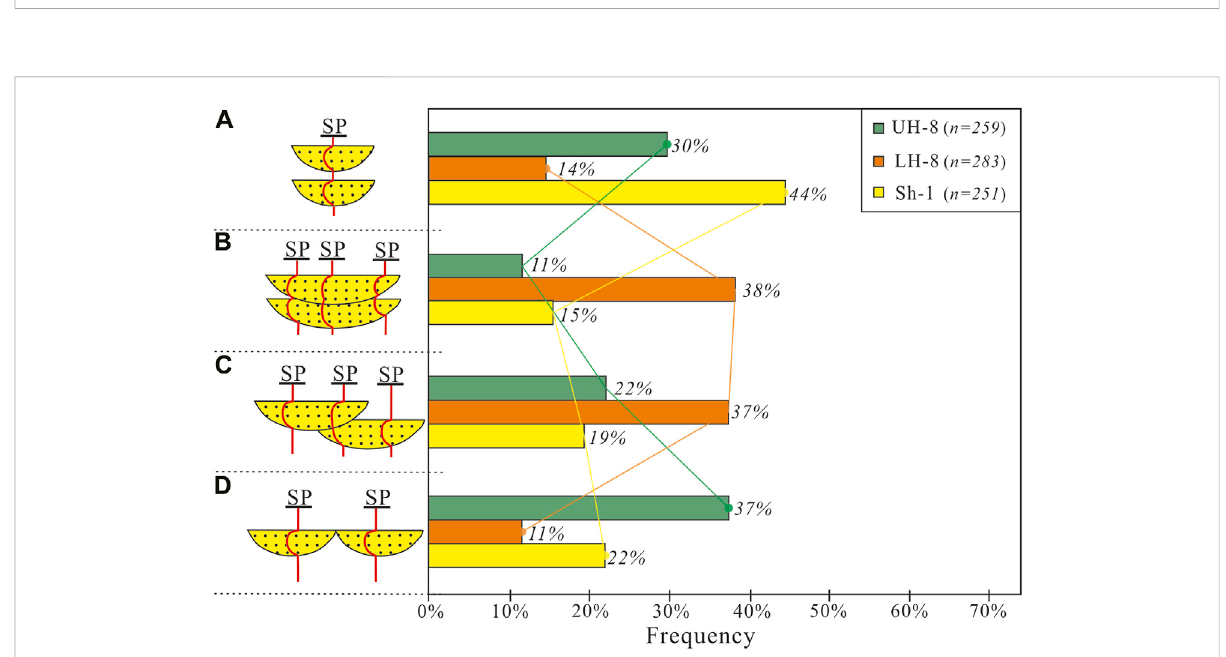
FIGURE 6 Frequency distribution of sand body stacking styles in the Sh-1 and He-8 members. (A) Isolated sand body, (B) vertically superimposed sand bodies, (C) tangentially superimposed sand bodies, and (D) horizontally bridged sand bodies. The data were obtained from logging data analysis of 88 exploration wells, including 259 complete sand bodies in the UH-8 member, 283 in the LH-8 member, and 251 in the Sh-1